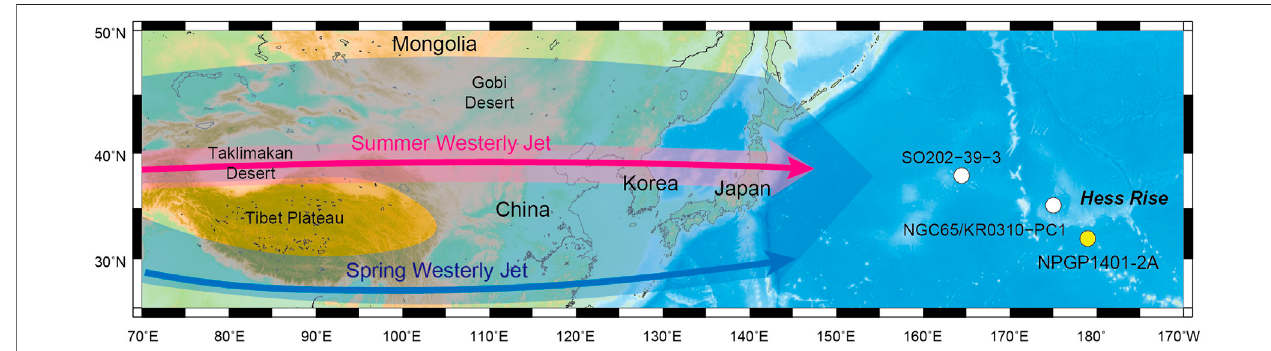
FIGURE 1 | Sampling location of sediment core NPGP1401-2A (yellow circle) and reference cores (white circles) NG65/KR0310-PC1 (Yamazaki and Kanamatsu, 2007)and SO202-39-3(Korffetal.,2016).Atmosphericcirculation patternstransportingdustfrom AsiainteriortotheNorth Paci fi catpresent areillustrated(Schiemann et al., 2009; Nagashima et al., 2011). Blue and pink arrows represent Westerly Jet in spring and summer, respectively, (bold arrows are the main axis of the